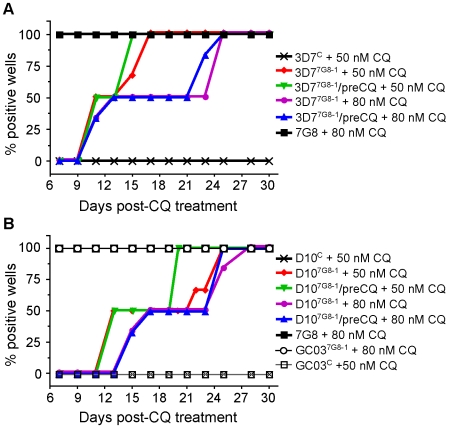
CQ recrudescence data for pfcrt -modified and parental clones.Lines were subjected to 50 nM or 80 nM CQ for 6 days and assayed for recrudescence every 2–3 days from days 7–30. Pooled data from two independent experiments were plotted as the percent of positive wells as a function of time post-CQ exposure. The panels show (A) 3D7 and (B) D10 clones and controls, including recombinant clones pretreated with 50 or 80 nM CQ. All no-treatment controls were positive on day 7 (as shown for 7G8+80 nM CQ), as was GC037G8-1 treated with both 50 nM and 80 nM CQ.